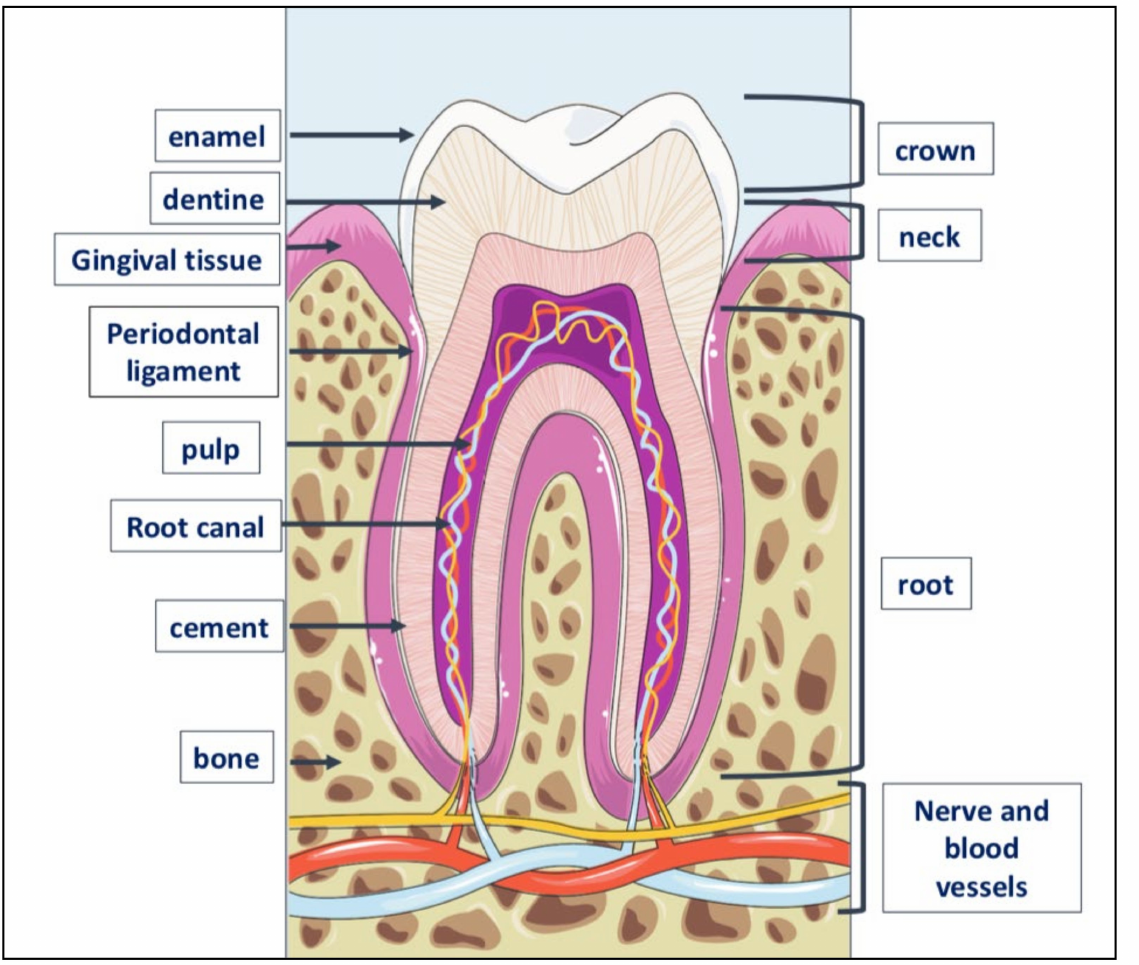
Figure 3. Tooth anatomy. The tooth consists of three parts: crown, the visible part of the tooth; neck or collar, the part surrounded by the gingiva or gum, and root located inside the alveolar bone to which is linked by the periodontal ligament. The outer part of the crown is covered with a layer of dental enamel, the hardest element in the human body; below the enamel is dentin, the substance that gives the teeth their color and composed of about 70% of inorganic material, the remaining 30% of organic material and water. Dentin is generated by odontoblasts, cells contained in the pulp, which is inside the dentin and includes also the nerve and blood vessels. The periodontium is a set of structures that are located around the tooth and which have a dual function: to keep the tooth firmly in the alveolar bone and to preserve the integrity of the mucous membrane of the oral cavity. It is made up of four tissues: the gum, the periodontal ligament, the root cement and the alveolar bone itself, that is, that bone, also called the hard lamina, which delimits the dental